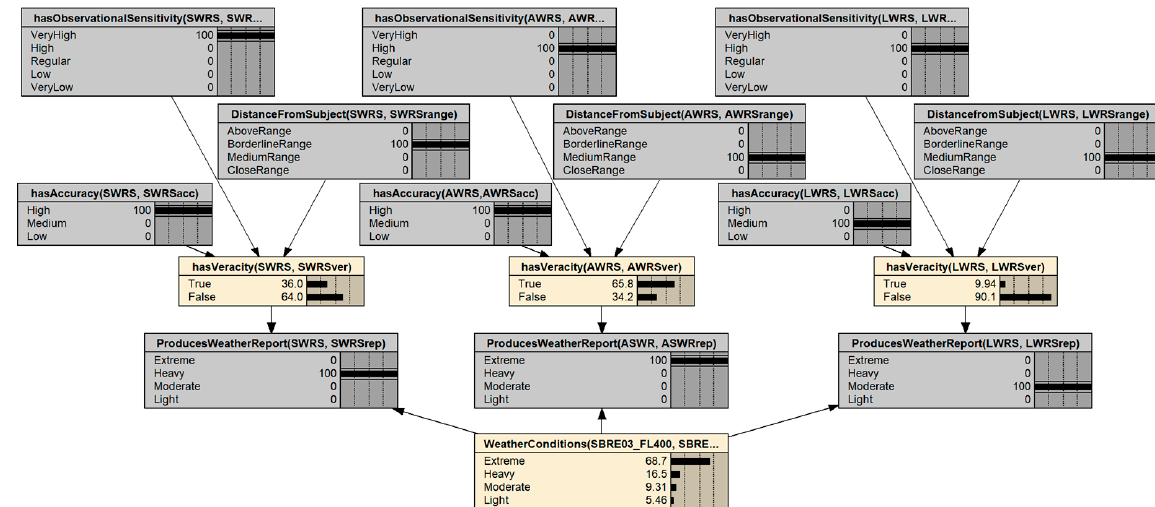
Figure 12. Query answering with the Situation Specific BN.